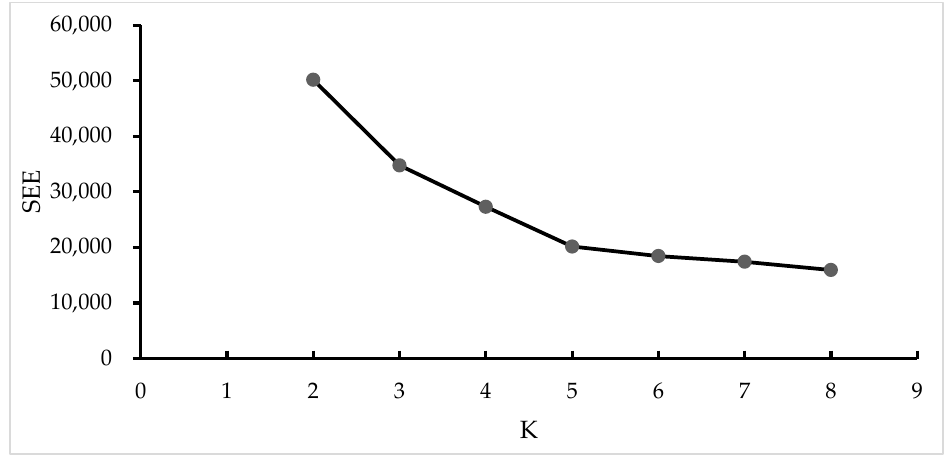
Figure 4. Relationship between K-value and SSE of standard K-means, showing that when the K < 5, the increase of the K-value will lead to a sharp decline in SSE, when the K > 5, SSE will no longer decrease significantly with the continuous increase of the K-value.